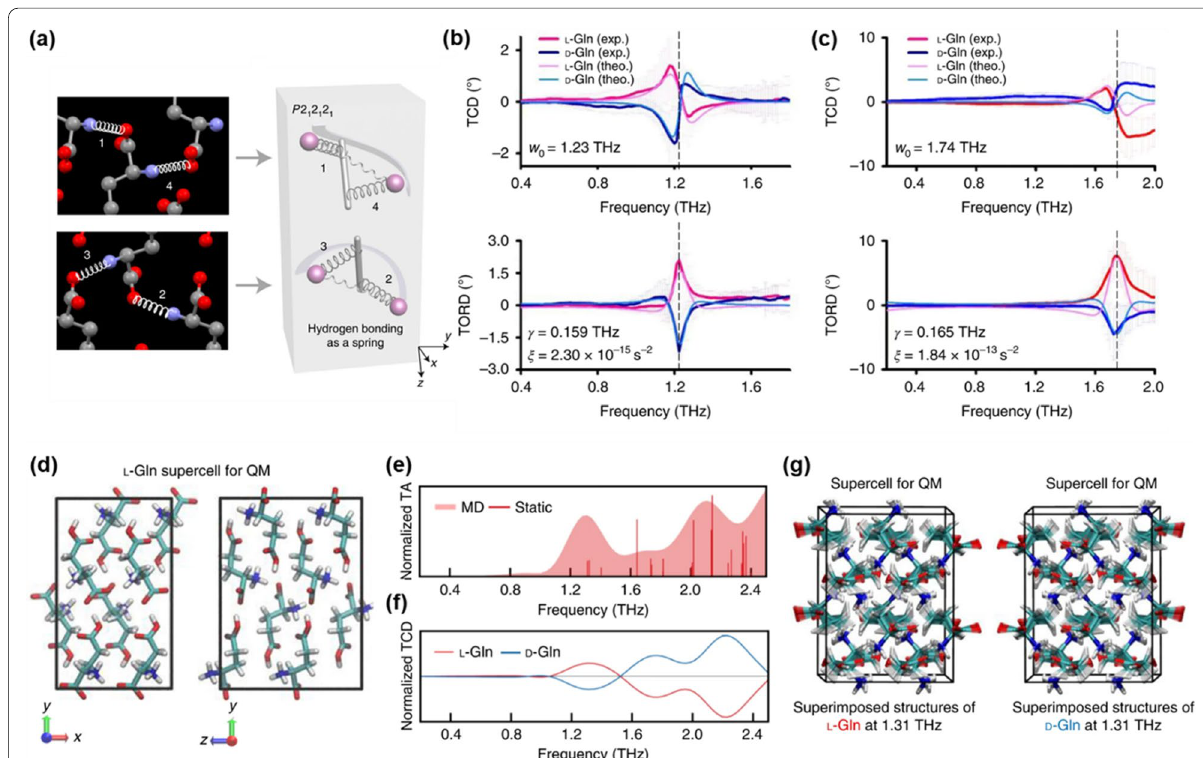
Fig. 22 a Schematic view of hydrogen bonds in l -Glu crystal cell as an example chiral biocrystals. Hydrogen bonds represented as springs in the model used for a description of chiral phonons. b , c Experimental and calculated THz CD and THz ORD spectra of Glu ( b ) and Gln ( c ). d Supercell of l -Glu used for the quantum mechanical (QM) computations of the THz spectra. e Normalized THz absorption (TA) spectra obtained from the calculations of the l -Glu supercell in d using the normal-mode analysis (vertical lines) and molecular dynamics (MD simulations at the QM level (solid surfaces). f Normalized TCD spectra from the same MD simulations at the QM level used for TA in e . g Superimposed structural variations of the l -Glu molecules at 1.31 THz. Reproduced with permission from